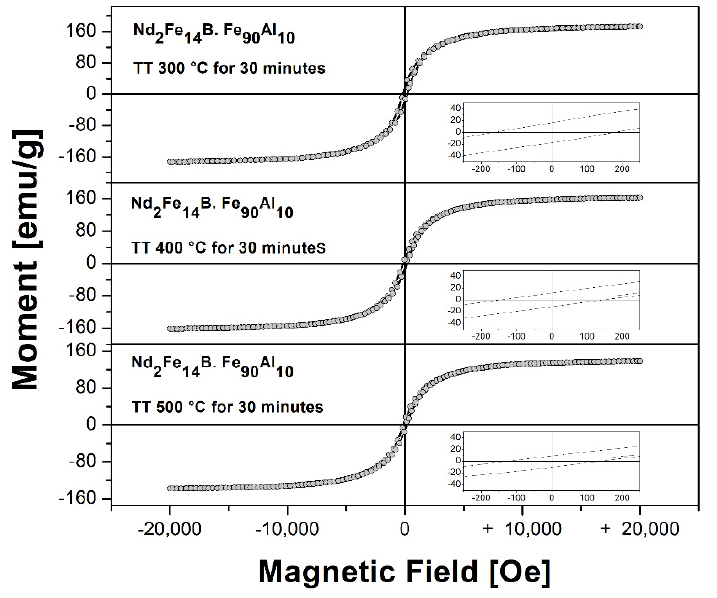
Table 9. Extrinsic magnetic properties of the Nd 2 Fe 14 B system. Fe 90 Al 10 sintered at 300, 400 and 500 °C, respectively.